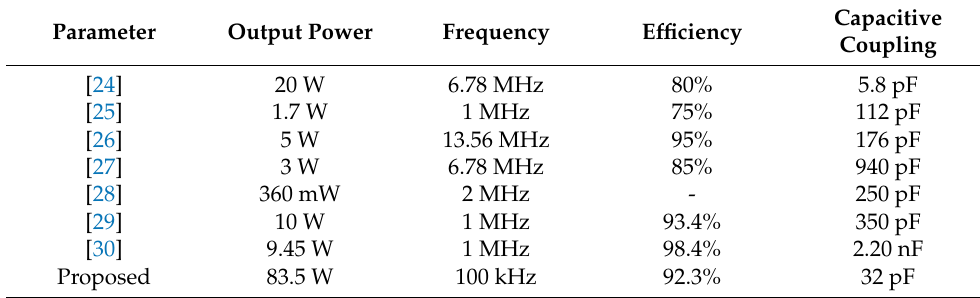
Figure 15. Experimental measurement of DC–AC conversion efficiency and output power at various C M values, where the blue line is the output power P O and the red line is the efficiency η . In Table 5, the comparison in terms of output power, efficiency, operating frequency, and capacitive coupling between Class-E circuits available in the literature is shown. Table 5. Comparison between literature